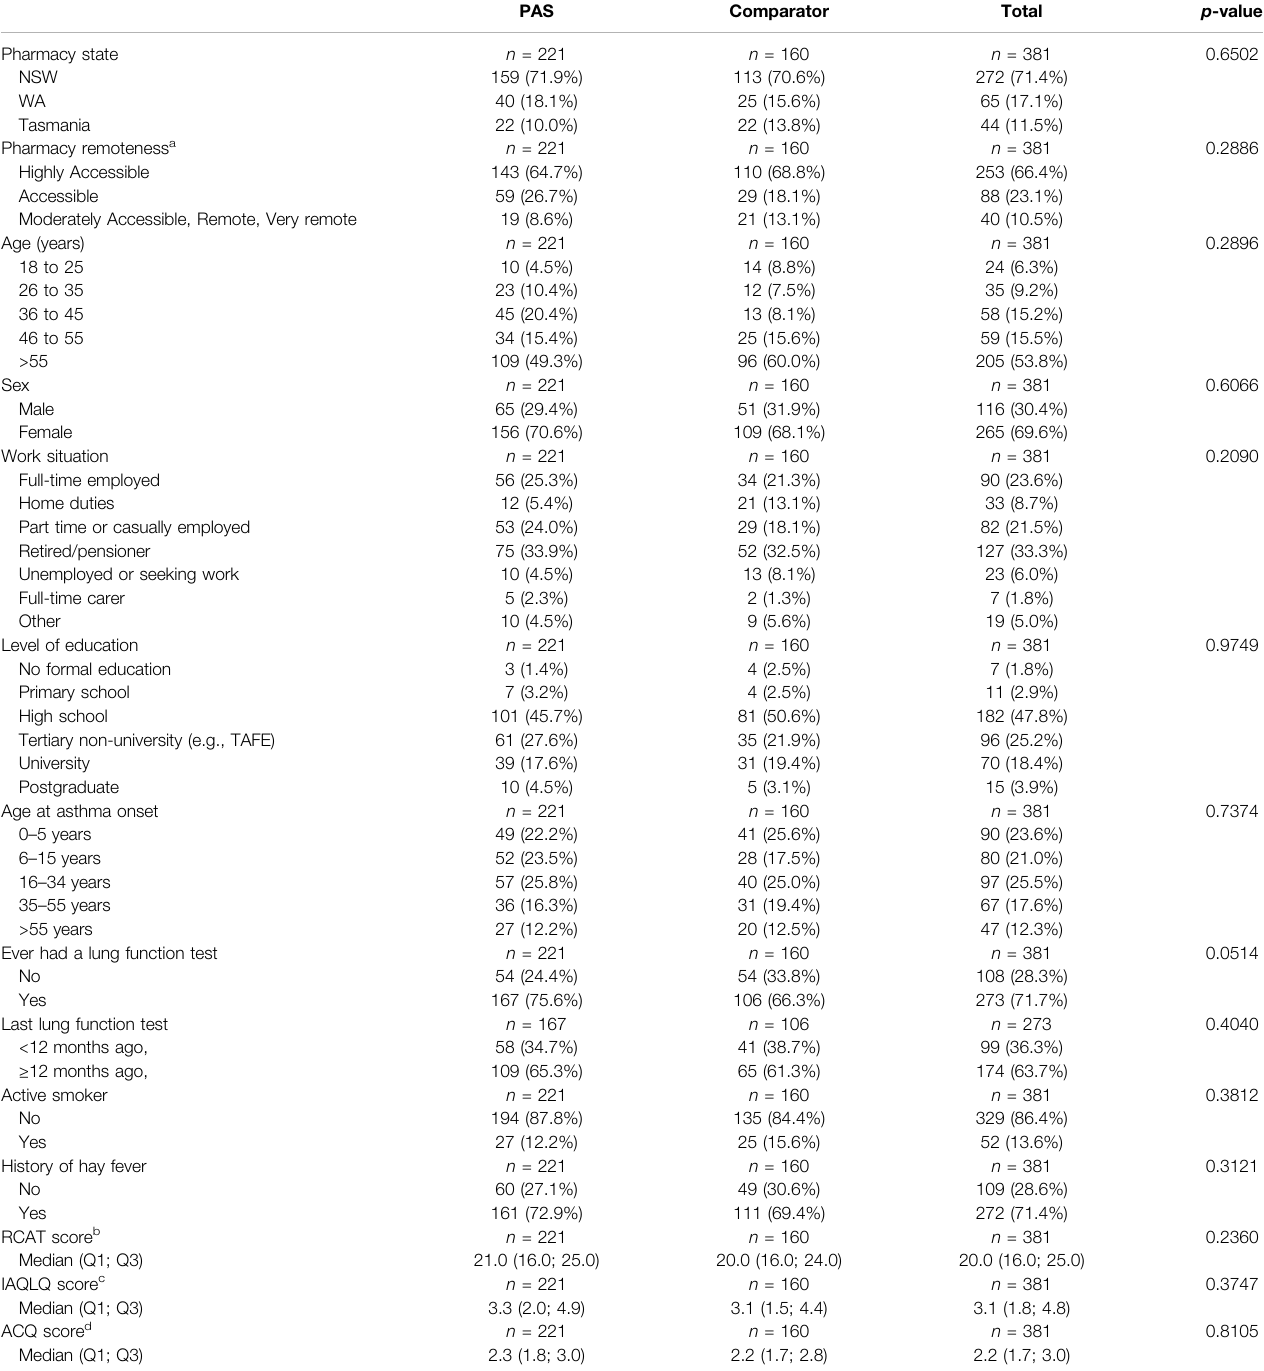
TABLE 1 | Patient